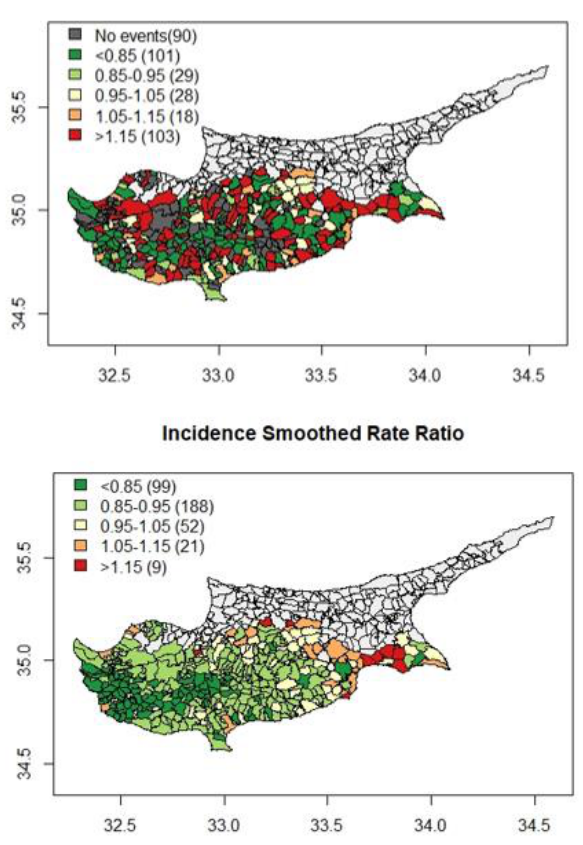
Figure 2. Choropleth maps of the CRC gender and age Standardised Incidence Ratios (SIRs) and smooth CRC gender and age Standardised Incidence Ratios (smooth SIRs).